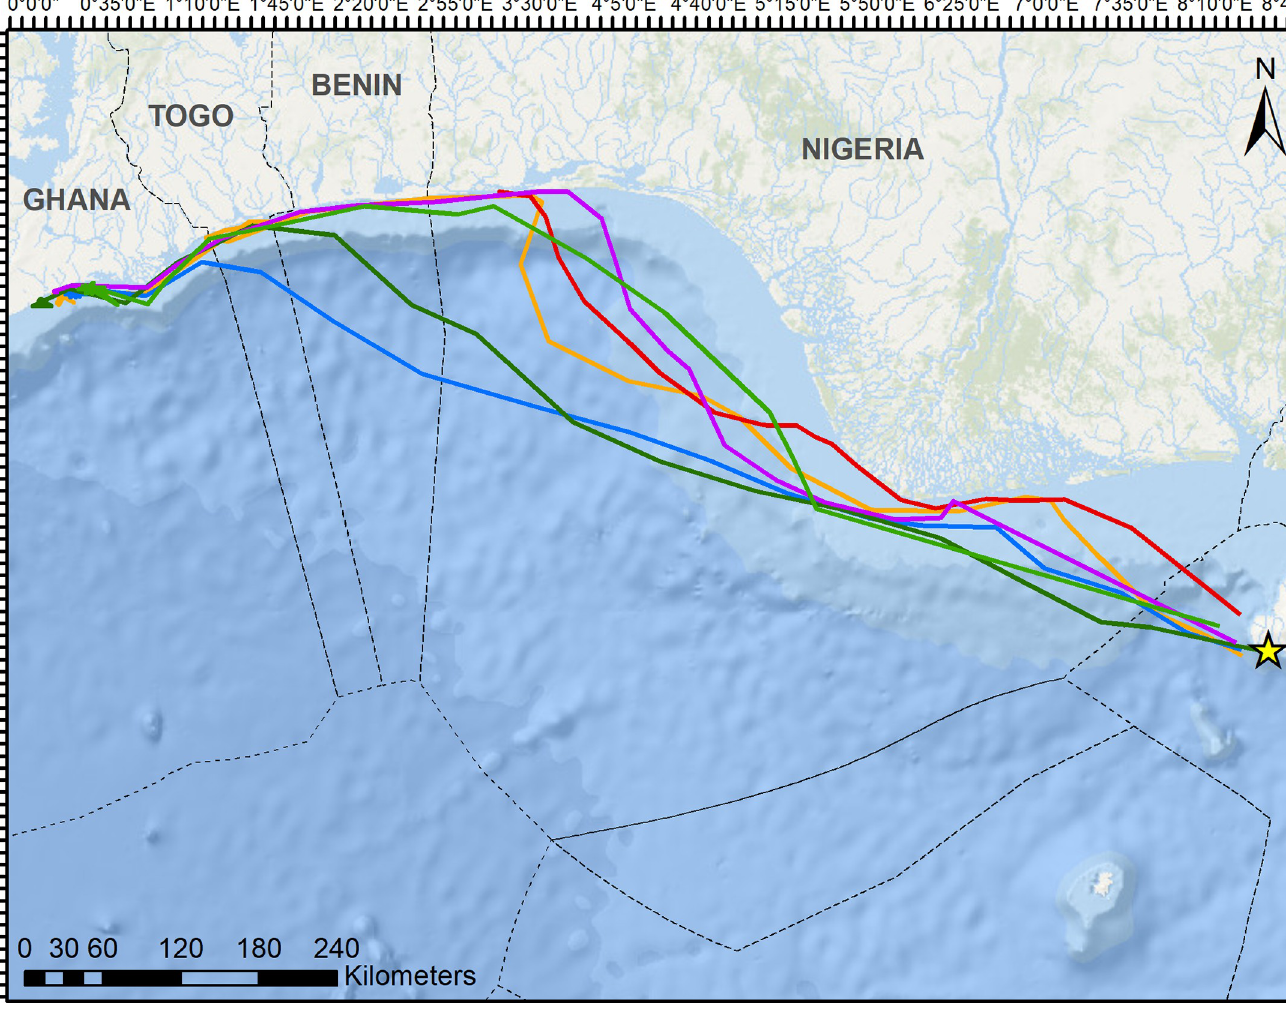
PLOS ONE | https://doi.org/10.1371/journal.pone.0213231 June 21,